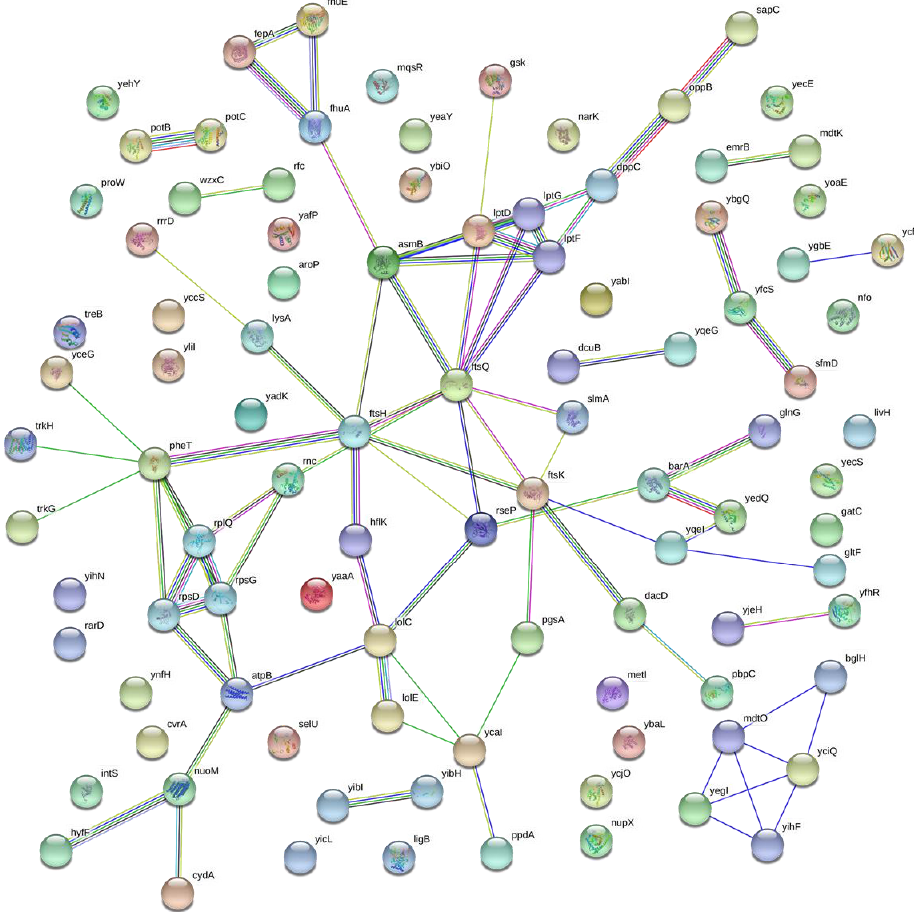
Figure 6. The functional interaction network analysis of proteins with severe growth effects by using STRING database. Network nodes represent proteins, and splice isoforms or post-translational modifications are collapsed. Edges represent protein-protein associations, and associations are meant to be specific and meaningful.